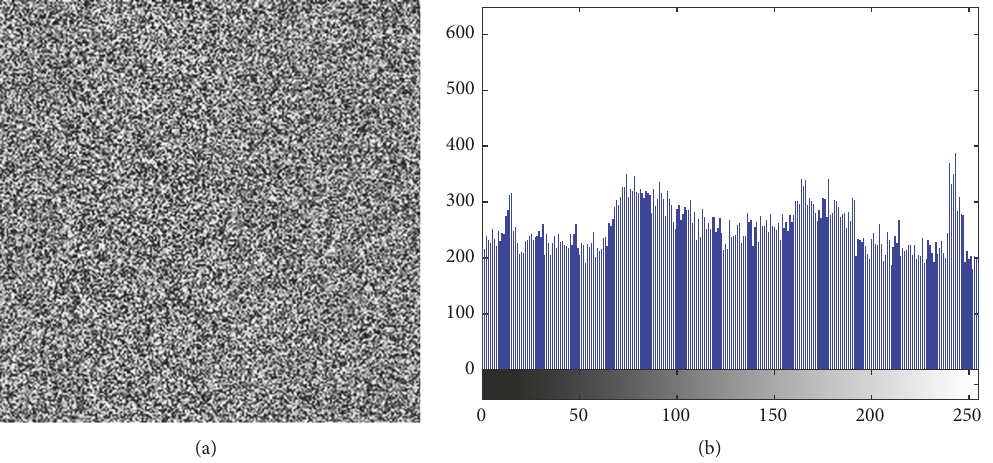
Figure 13: Case 1 : (a) encrypted image and (b) encrypted histogram.